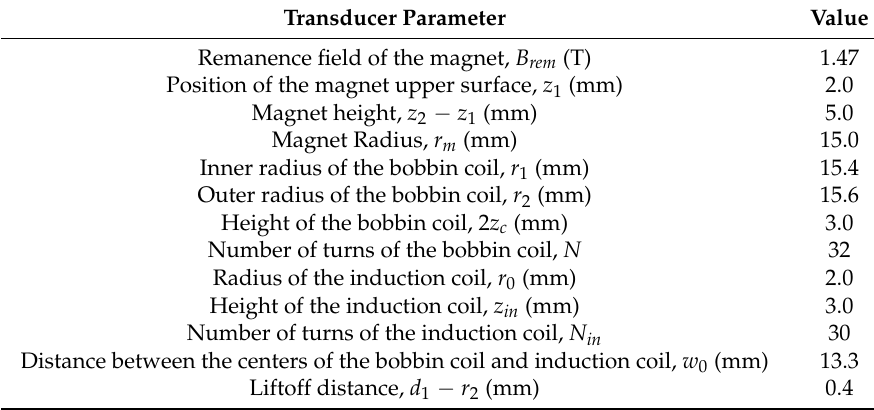
Table 1. Parameters of the proposed transducer.